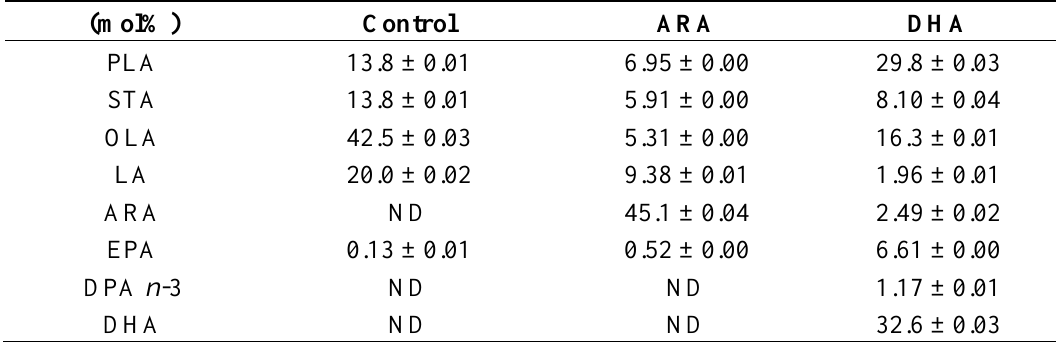
Table 1. Composition of fatty acids in control, ARA, DHA